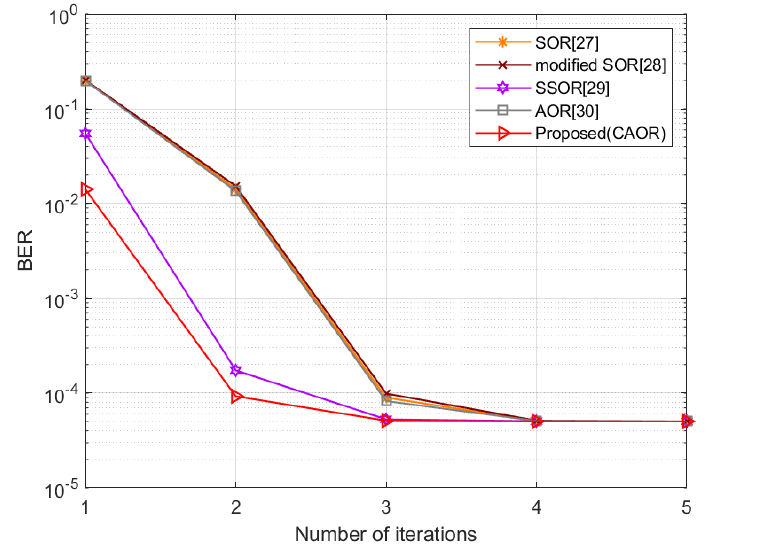
Figure 10. BER performance vs. number of iterations with N R × N T = 256 × 16 and SNR = 40 dB.